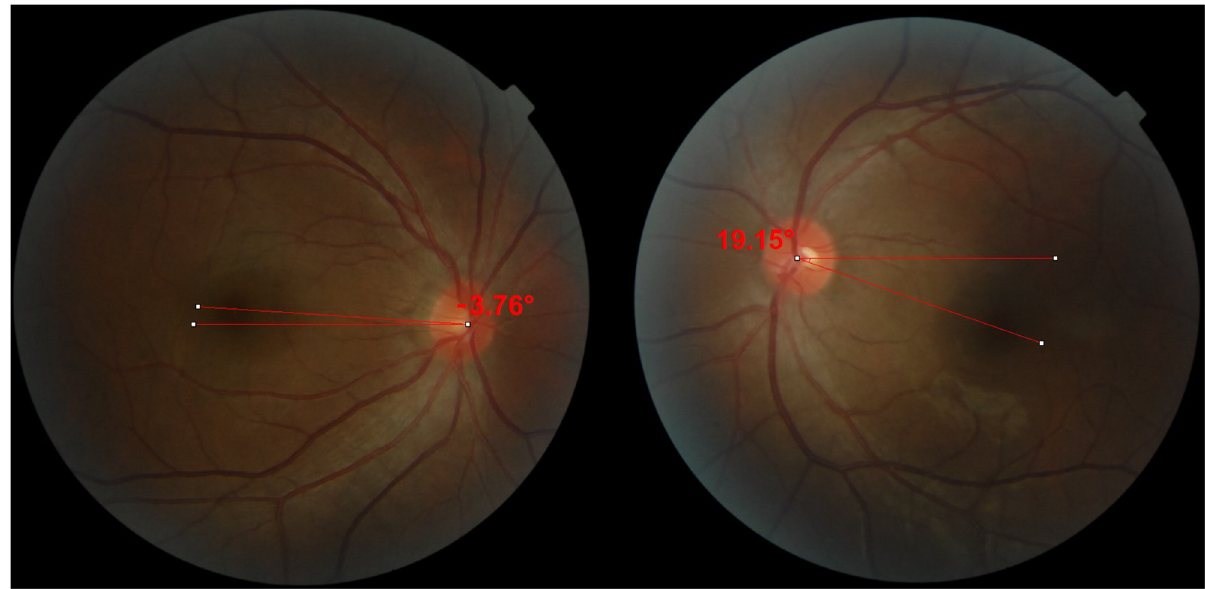
Fig 1. The measurement of the disc-foveal angle (DFA) using fundus photographs. The DFA is -3.76˚ in the right eye and 19.15˚ in the left